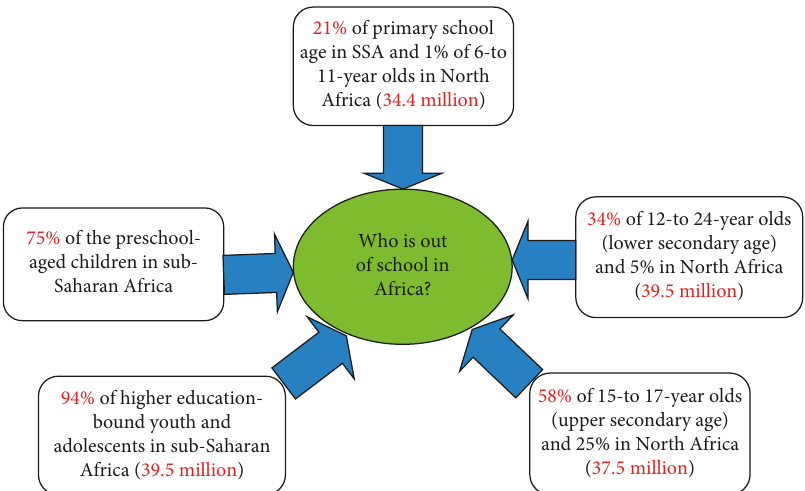
Figure 1: Percentage of children who are out of school in Africa (adapted from [34]).